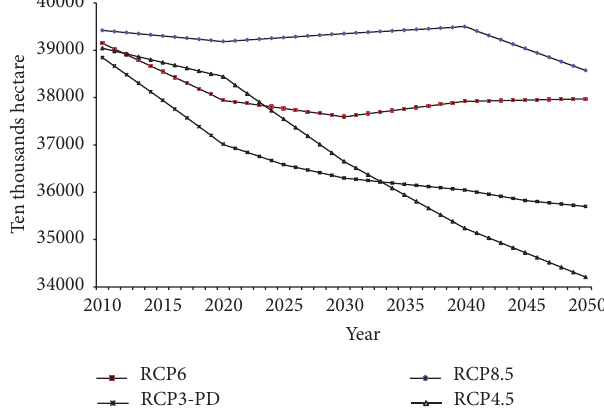
Figure 4: Changing trends of the projected grassland area under the RCPs